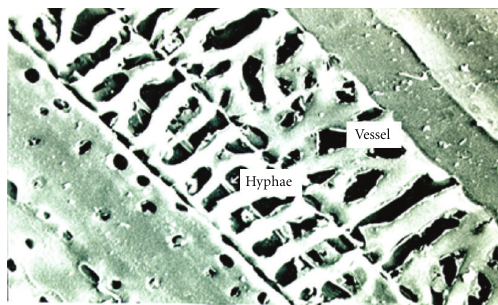
Figure 4: Brown rot hyphae penetration in vessel lumen (longitu- dinal section,